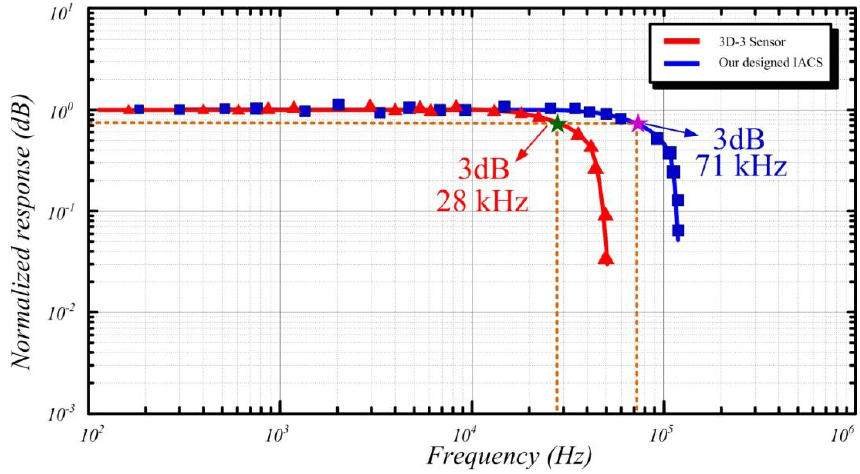
Figure 10. Comparison of the frequency response of the proposed sensors.